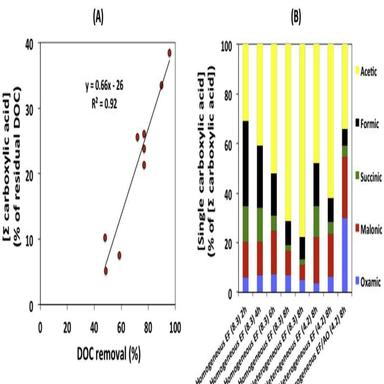
e Generation of short-chain carboxylic acids during EAOPs: (A) correlation between DOC removal (%) and proportion of carboxylic acids among the residual DOC; (B) evolution of the proportion of each single carboxylic acid among the total carboxylic acid concentration as a function of configurations and operating conditions (current density in bracket, mA cm-2 ).